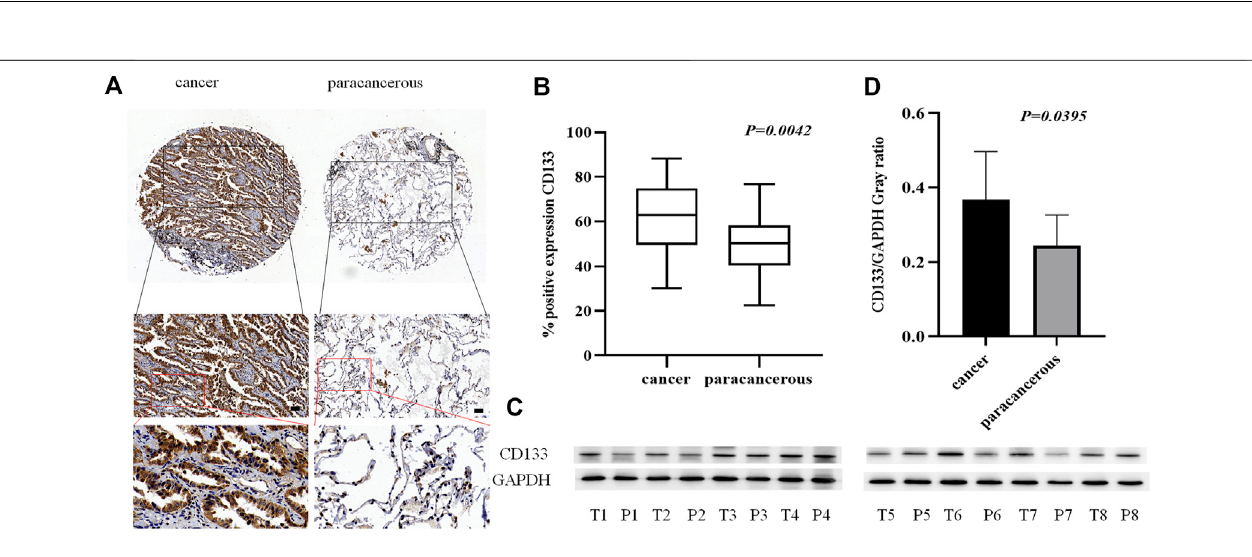
FIGURE 2 | The expression ofCD133 in lung adenocarcinoma cancer tissue and paracancerous tissue. (A) . IHC detection of CD133 expression in lung adenocarcinoma cancertissueandparacanceroustissue.BrownmeansCD133positivereaction,CD133ismainlyexpressedinthecytoplasm,andbluemeansnuclearstaining.Allbarinthe fi gure (cid:1) 50 μ m. (B) . GraphPad Primes 8 statistics found that CD133 expression is higher in cancer tissue than in paracancerous tissue ( p (cid:1) 0.0042). (C) . Western blot detects the expressionofCD133infreshcancertissueandparacanceroustissueof8lungadenocarcinomapatients. (D)